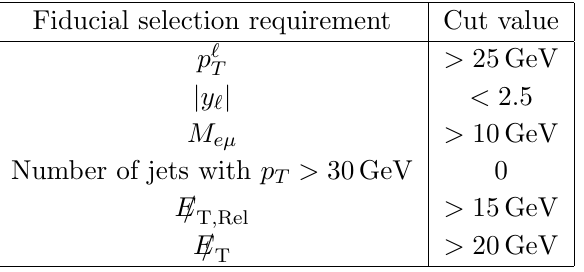
Table 1 . De(cid:12)nition of the WW ! e(cid:22) (cid:12)ducial phase space, where p ‘ tum and rapidity of either an electron or a muon, M e(cid:22) is the invariant mass of the electron-muon pair, E= is the missing transverse energy, and E= T